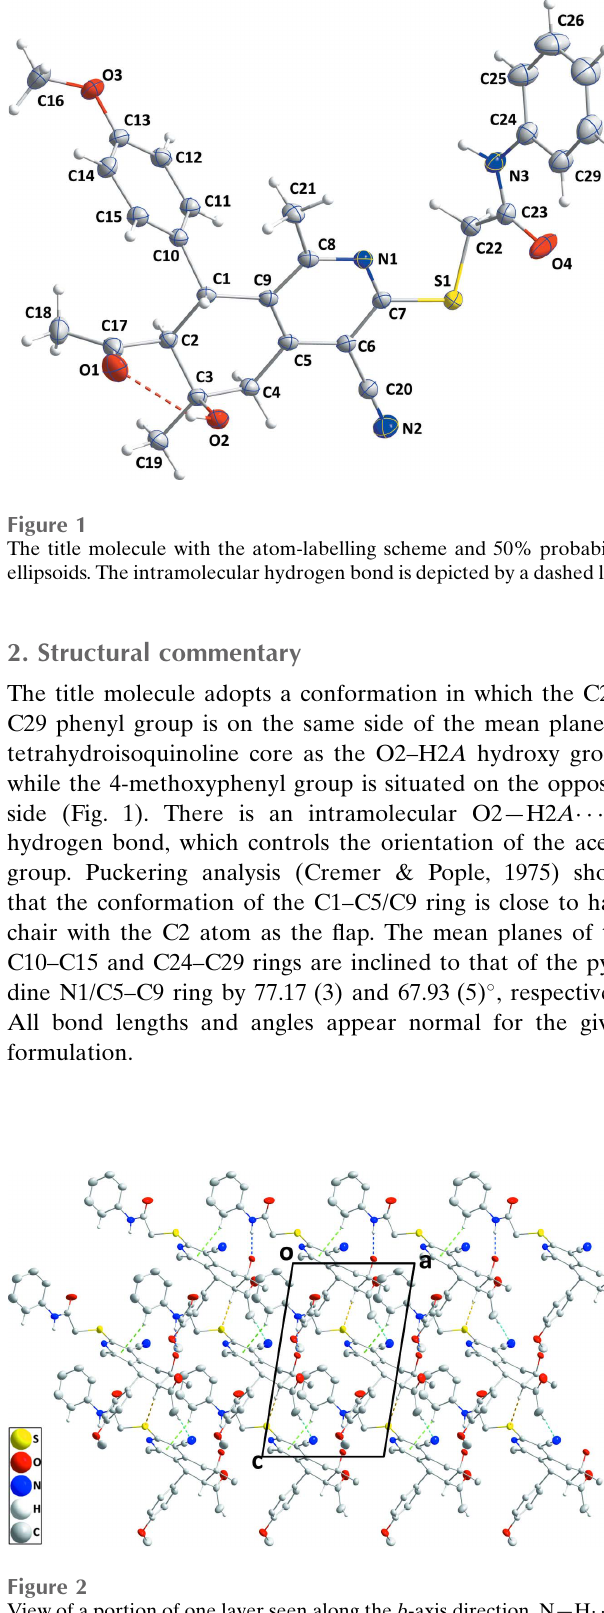
Figure 3 View of portions of two layers showing their connection by C—H (cid:2)(cid:2)(cid:2) O hydrogen bonds (black dashed lines). Other intermolecular interactions are depicted as in Fig. 2.